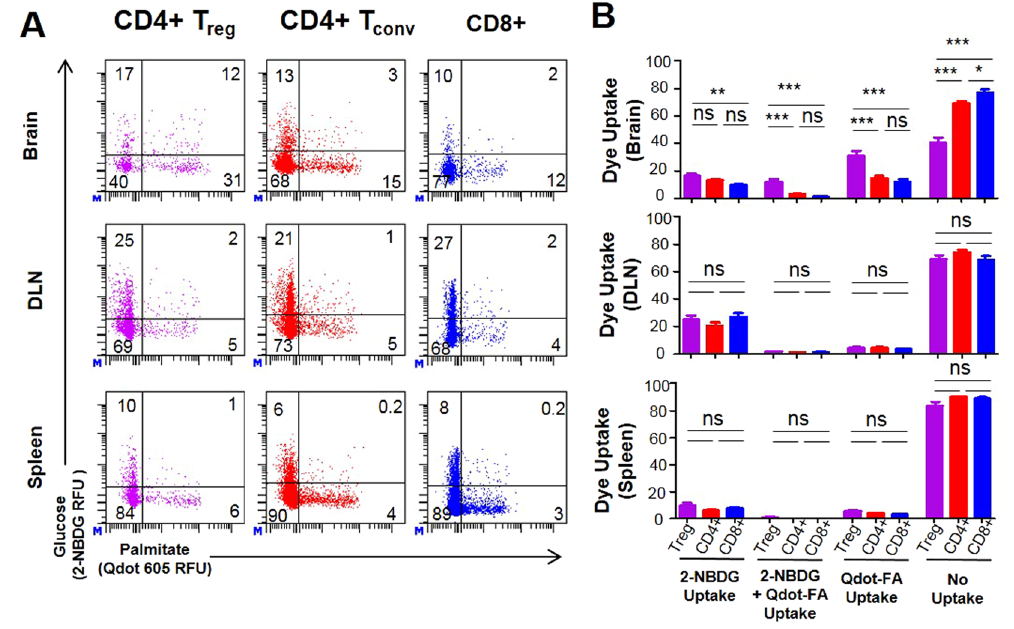
Figure 6. Ex-vivo analysis of both FA-Qdot and Glucose Uptake of T-cells from glioma-bearing mice. Wild- type C57/Bl6 mice were implanted with 4x10^5 GL-261 astrocytoma cells, and after two weeks of tumor growth, T cells were isolated and analyzed via flow cytometry. In ( A ) CD4 + CD25 + , CD4 + CD25 − , and CD8 + T cells were assessed for FA-Qdot, and 2-NBDG (fluorescent glucose analog) uptake was examined using ex- vivo labeling for flow cytometry. In ( B ), the comparison of dye uptake across different T cell subsets; in ( C ), an in-depth comparison of fatty acid, 2-NBDG, or simultaneous uptake compared across different tissues in each subset measured. Results are compiled from 5 animals and is representative of 2 experiments. Statistics are calculated as the percentage of positive population ± SEM. One-way ANOVA, followed by Tukey’s post-hoc analysis, was used to calculate significance. p < 0.05 * ; p < 0.01 ** ; p < 0.001 *** . RFU = Relative Fluorescence Units; ns = not